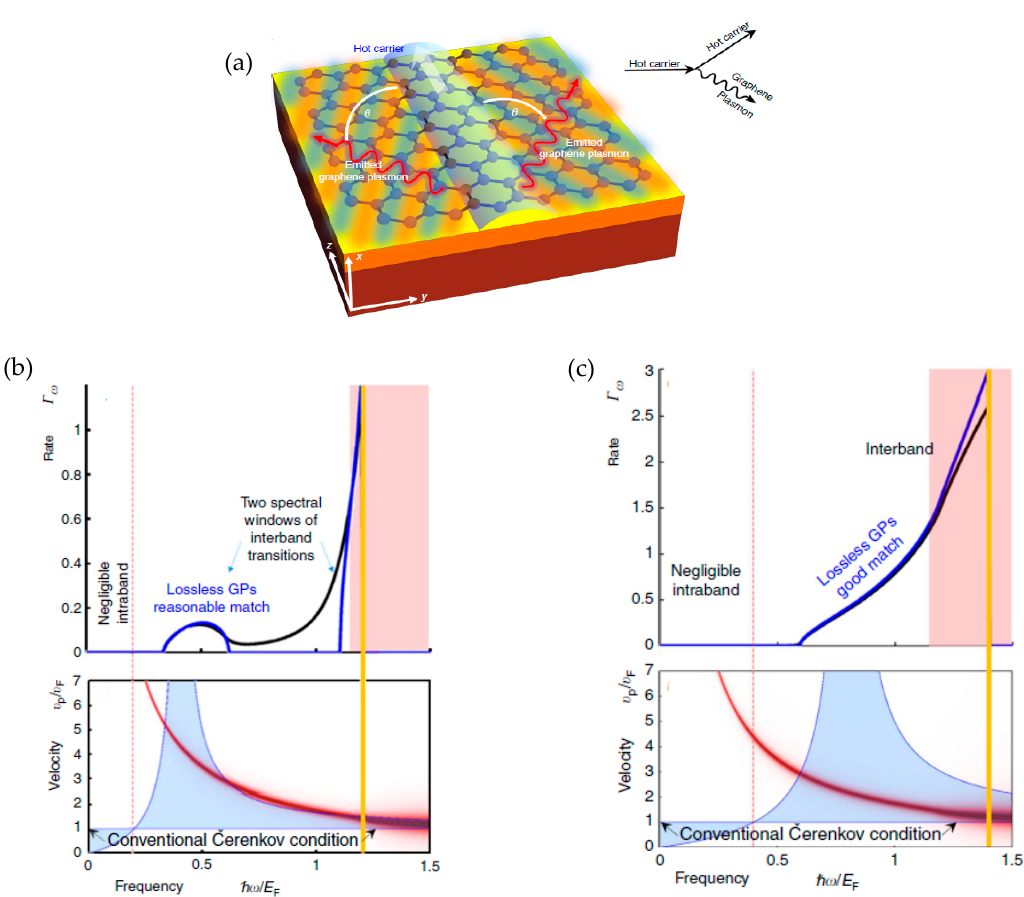
Figure 8. The sketch illustrates the 2D Cerenkov emission process in graphene. ( a ) GP emission from the graphene layer by the inner flow of hot carrier, diagram demonstrating the GP emission-related process due to the hot carrier in the graphene layer. ( b ), ( c ) illustrates the spectrum of the C ˇ E GP emissions, the red region corresponds to the GP losses and emission losses presented in black, where emission approximation is depicted with blue. The orange line shows the spectral cut off because of the Fermi sea, where all available states are filled. In the lower part of ( b ) and ( c ), the red curve depicts the GP related phase velocity, and its thickness corresponds to the GP losses [60].